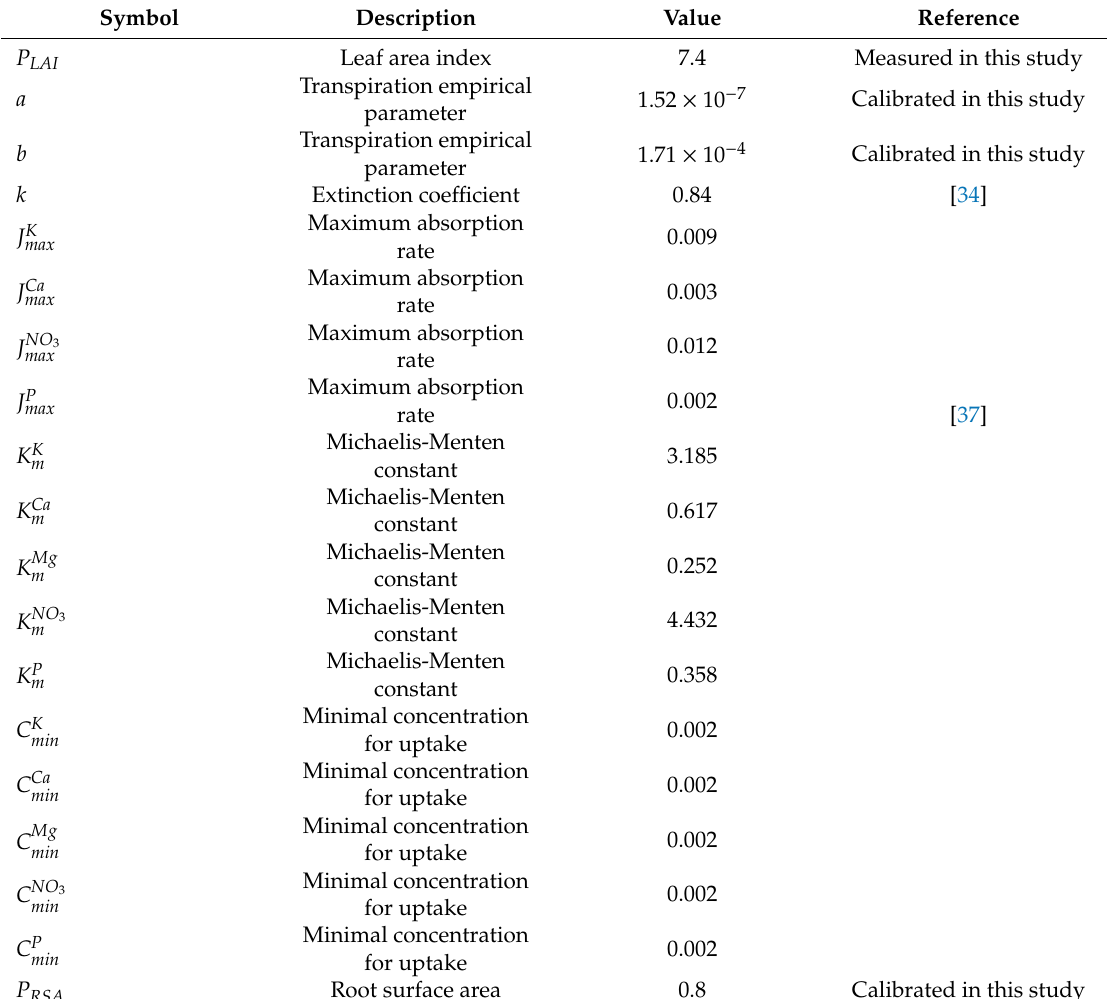
Table 1. Parameters used for the simulations of the soilless culture